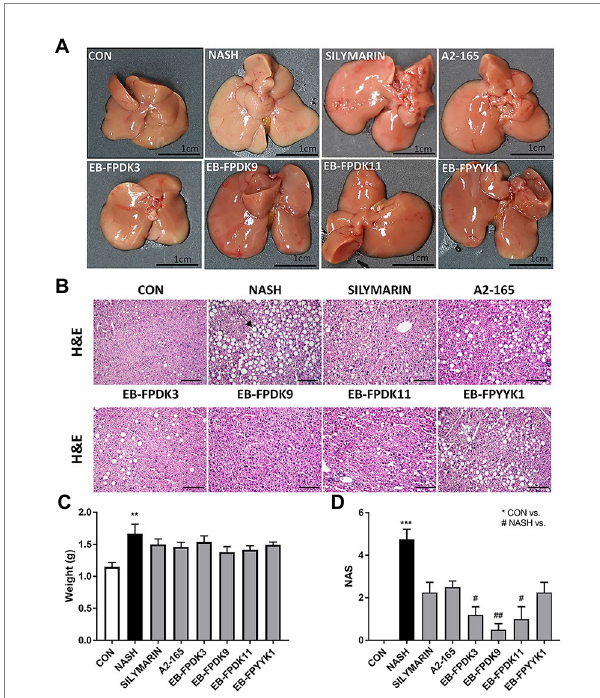
FIGURE 4 Effects of Faecalibacterium prausnitzii in preventing lipid accumulation in and damage to the liver. (A) Photographs of mice liver. (B) Microscopic images of liver tissue after H&E staining. Scale bar: 0.1 mm. (C) Weights of mice liver samples. (D) NAFLD Activity Score (NAS). The data are presented as the mean ± SEM ( n = 12). The black arrow indicates the lipid deposition site in the liver tissue Statistical analyzes were performed using Kruskal–Wallis one-way ANOVA with Dunn’s test, ∗∗ p < 0.01, ∗∗∗ p < 0.001 versus the CON group; # p < 0.05, ## p < 0.01 versus the NASH group. NAFLD: nonalcoholic fatty liver disease, NASH: nonalcoholic